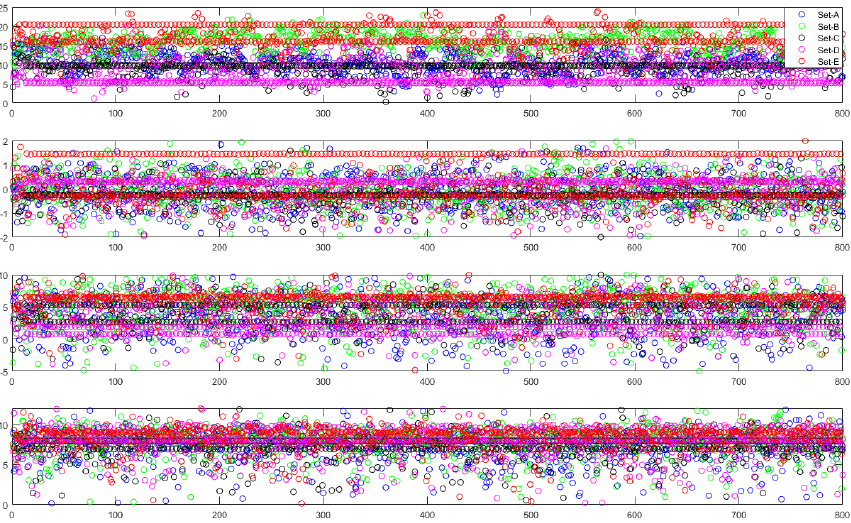
Figure 6. The first series of Mel-frequency cepstrum coefficients (MFCCs) of five sets (sets A, B, C, D, and E) in Case 4, for product function1 (PF1) to product function4 (PF4) from